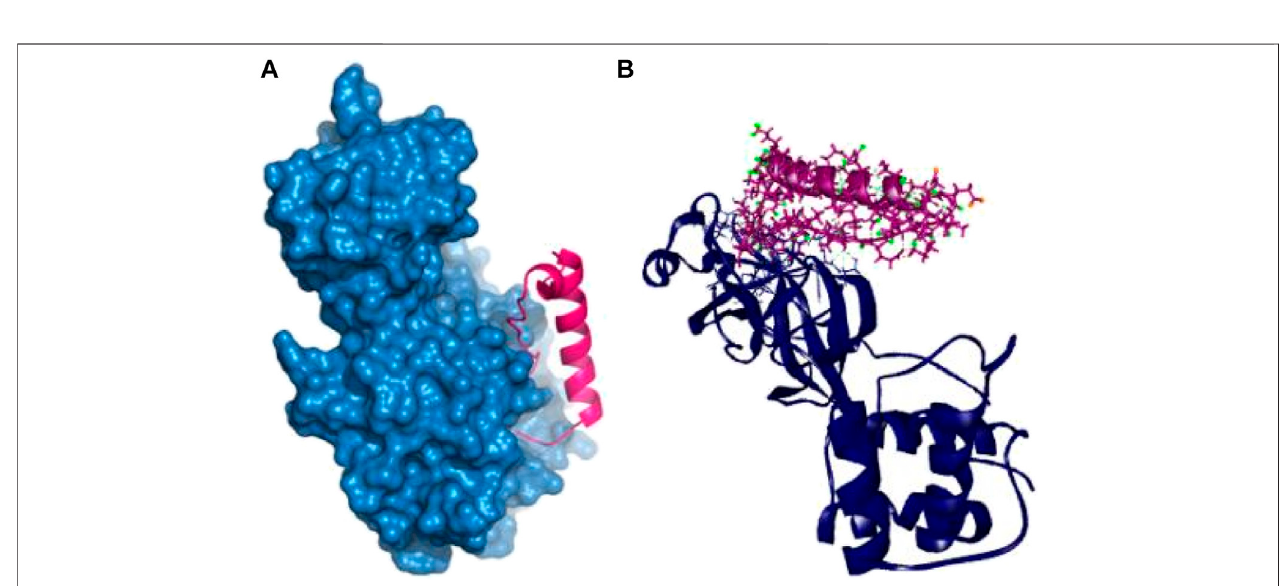
FIGURE 4 | Nonbonded interaction of P74 and main protease enzyme (A,B)